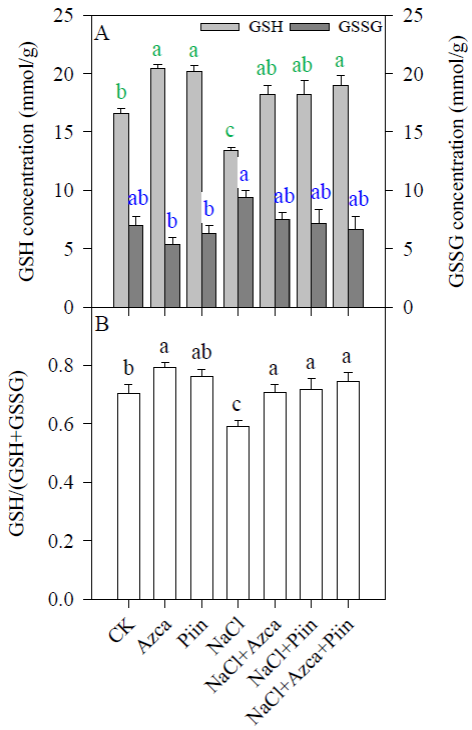
Figure 8. Changes in GSH and GSSG concentrations and the ratios of GSH/(GSH + GSSG) in leaves of tomato plants under different treatments. ( A ): GSH and GSSG concentrations; and ( B ): the ratios of GSH/(GSH + GSSG). Results were shown as mean ± SE ( n = 3). Green and blue lowercases indicate statistical differences in GSH and GSSG concentrations, respectively. The means with the same lowercases indicate that the differences were insignificant ( p > 0.05).